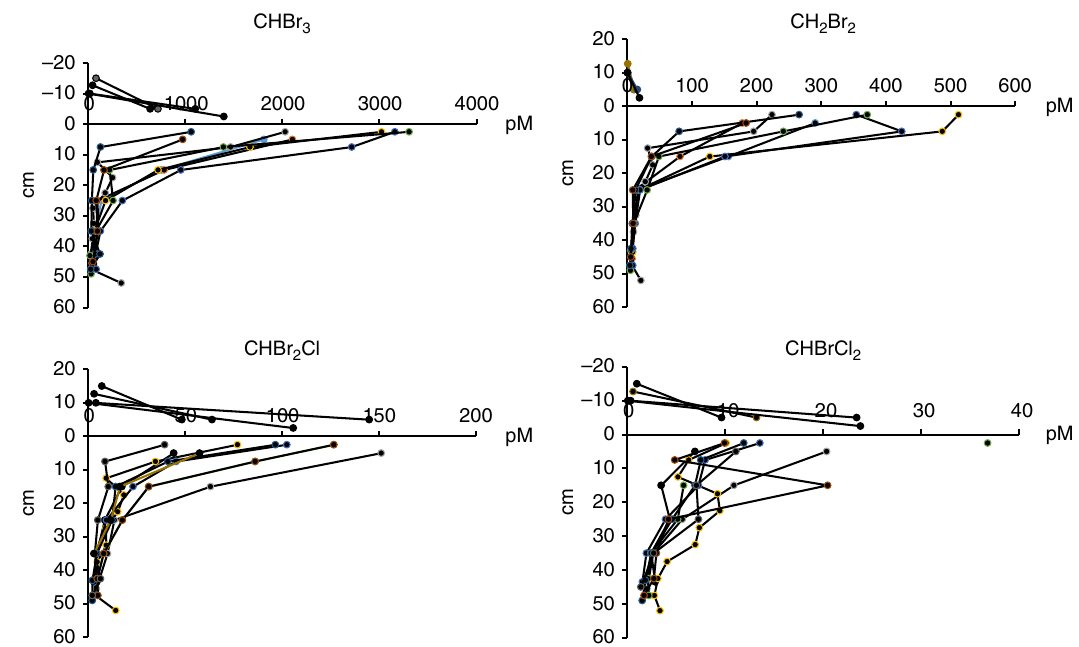
Fig. 2 Pro fi les of brominated halocarbons (CHBr 3 , CH 2 Br 2 , CHBr 2 Cl, and CHBrCl 2 ) in sea ice and snow. Data from station 506 include eight sea ice core pro fi les and four snow pro fi les. The line at 0 cm indicates the sea ice – snow interface. The total snow depth was 17 cm. The complete concentration data set is found in Supplementary Tables 3 –